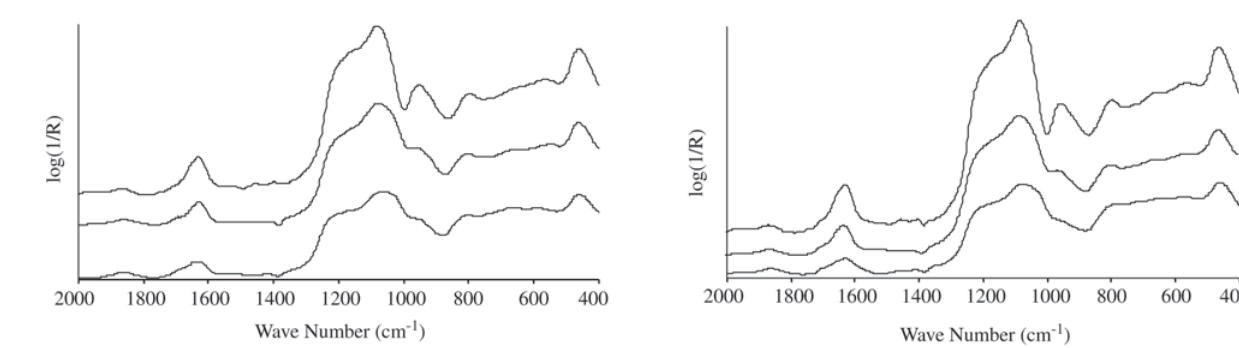
Figure 5. DRFTIR spectra of STC samples treated at 110 °C, 600 °C and 800 °C (top to bottom).